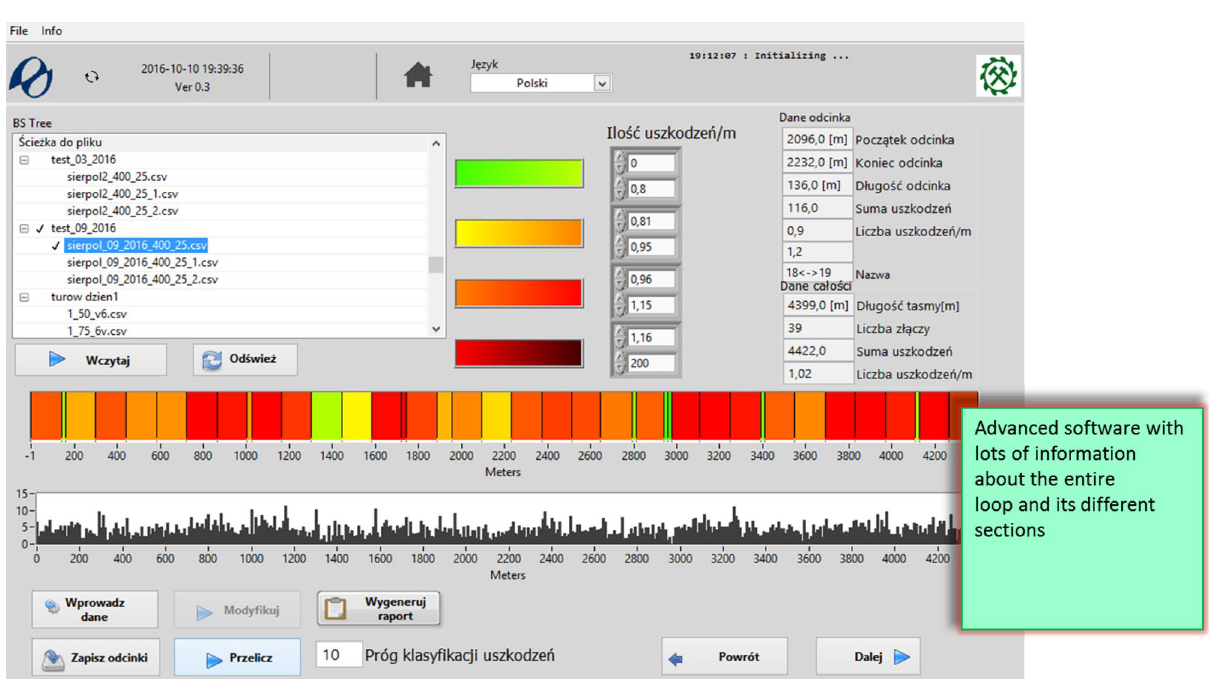
Figure 3. Belt loop on a conveyor viewed in DiagBelt with averaged and color-coded identification of the condition of successive belt sections and with a histogram of damage density along the belt axis (screenshot of DiagBelt proprietary software, version 1.0, http:// diagb elt. pwr. edu.